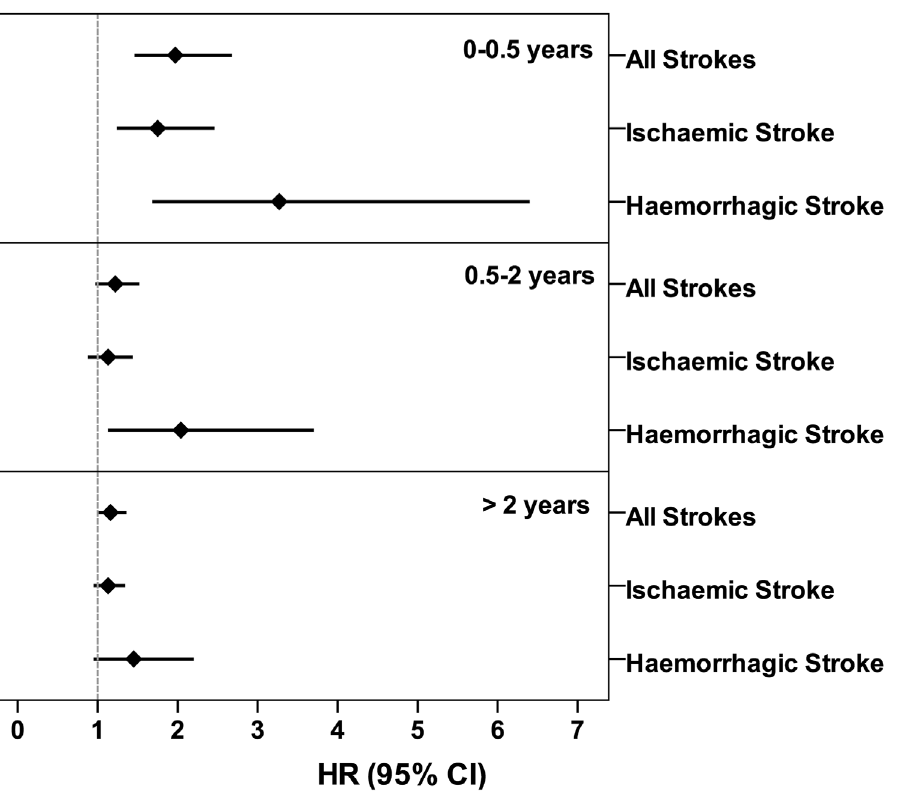
Figure 1. Age-, gender- and co-morbidities-adjusted hazard ratios for development of stroke following septicaemia at various time intervals.